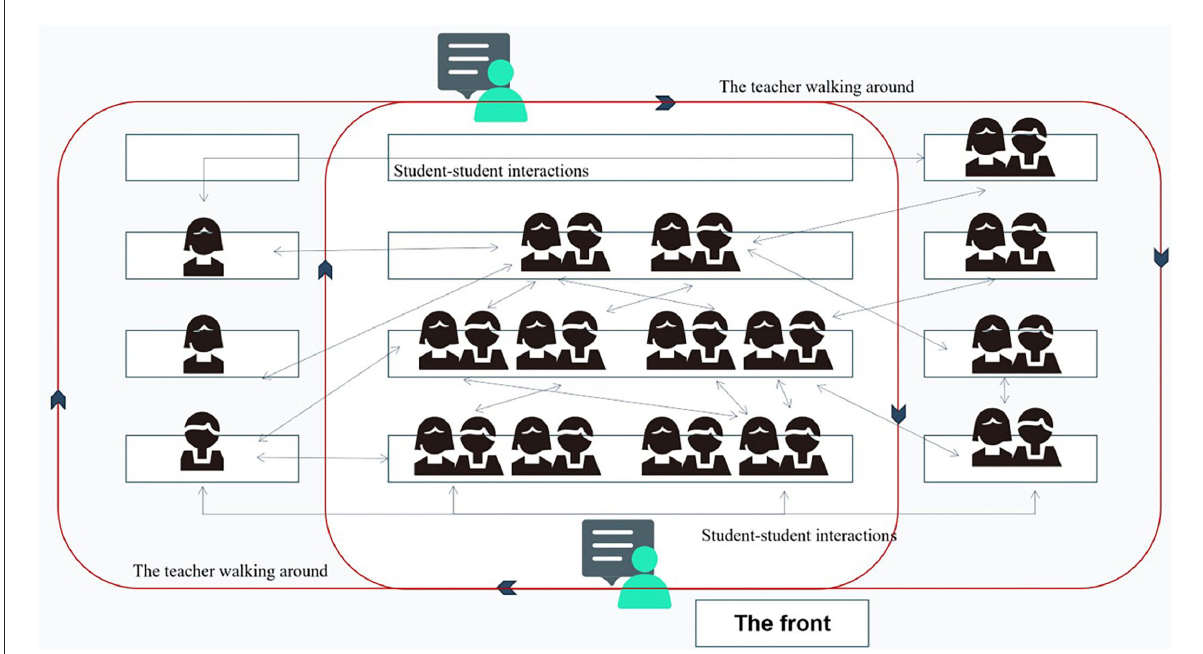
FIGURE1 Teacher–student and student–student interactions in Christine’s academic writing